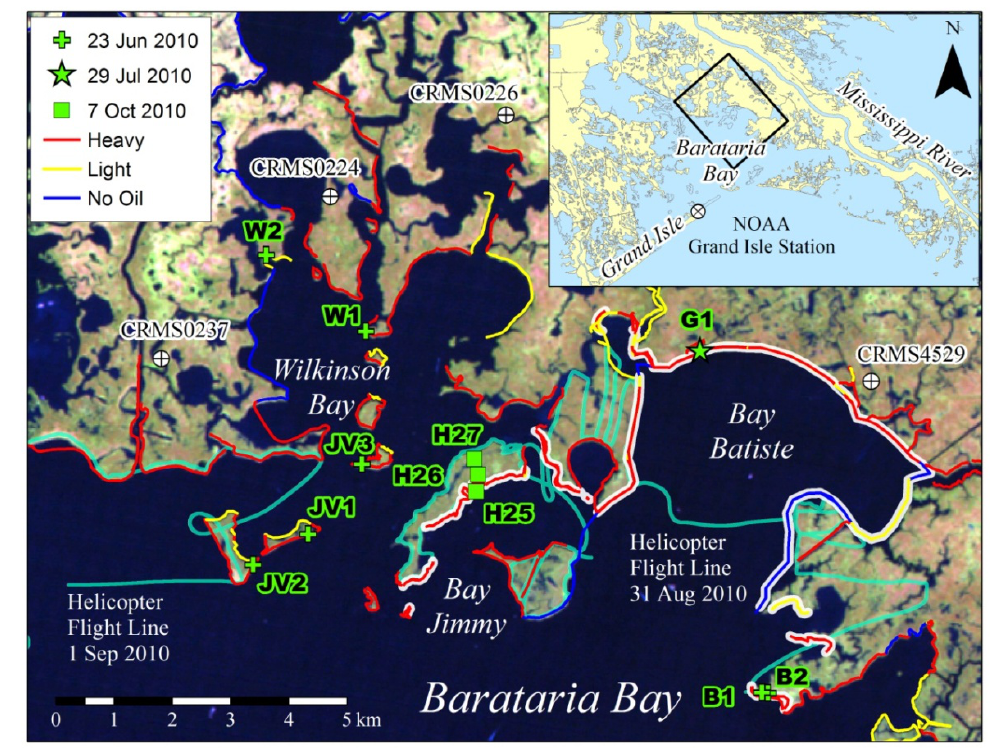
Figure 2. A Landsat Thematic Mapper image of study area depicting locations and dates of ground observations of oil contamination from the Deepwater Horizon spill; flight lines of the helicopter surveys; shoreline oil-spill categories from Shoreline Cleanup Assessment Techniques (SCAT) [14]; and Coastwide Reference Monitoring System (CRMS) water level station [15] and NOAA metrological station [16] locations. White lines highlight the earliest SCAT-documented shoreline oil impacts on 11 June